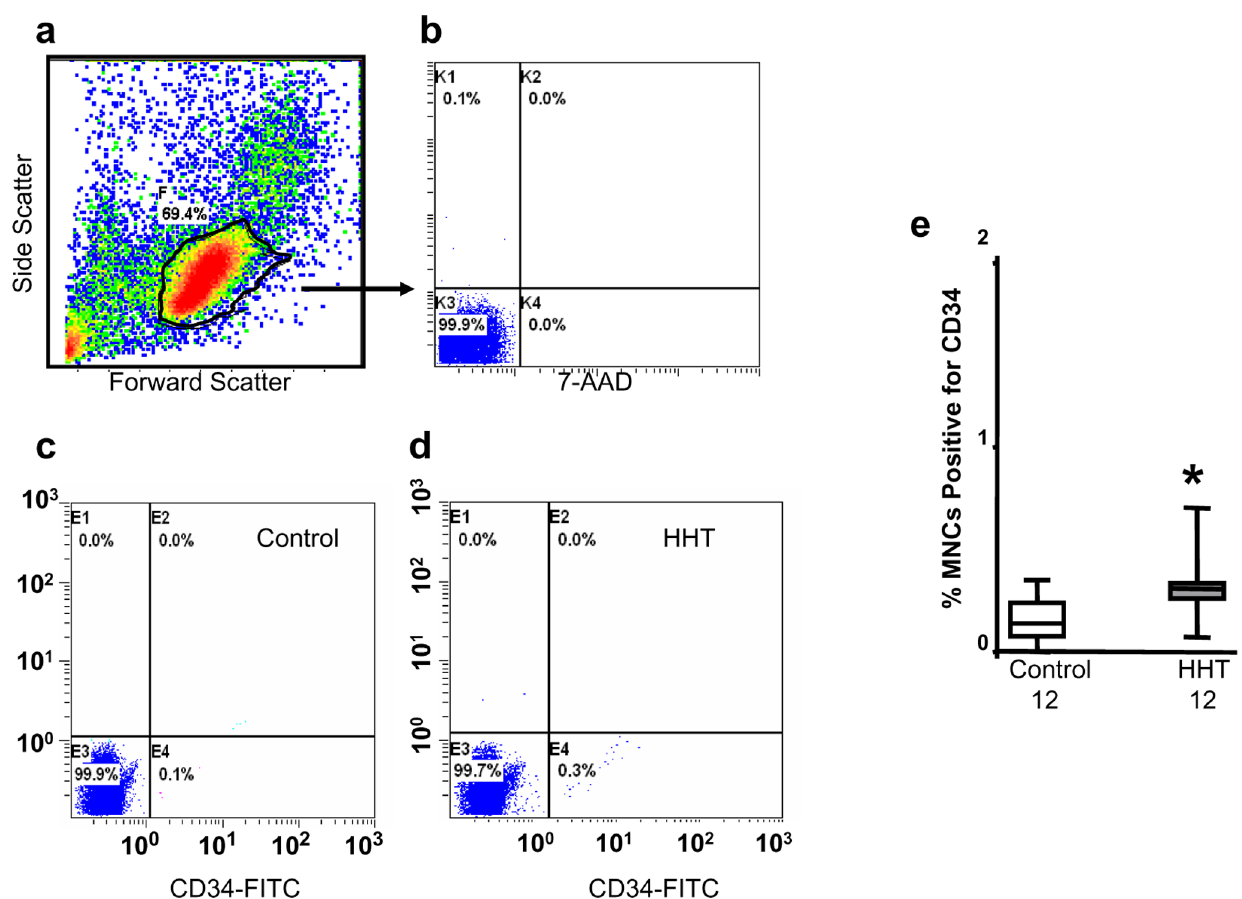
Figure 1. Increased CD34 + cells in PBMNCs isolated from HHT patients. Flow cytometric analysis showed that PBMNCs consisted of cells with different size and granularity (a), monocytic/lymphocytic population stained by fluorescent dye 7-AAD indicated over 99% cell viability (b). Manually gated cells for CD34 staining analysis were performed. A representative dot plot of CD34 analysis for a healthy volunteers and a HHT patient was shown in c and d, respectively. About 0.3% CD34 + cells were identified in PBMNCs from HHT patients, which was significantly higher than that in the control samples (e). * p , 0.05, compared with healthy controls.